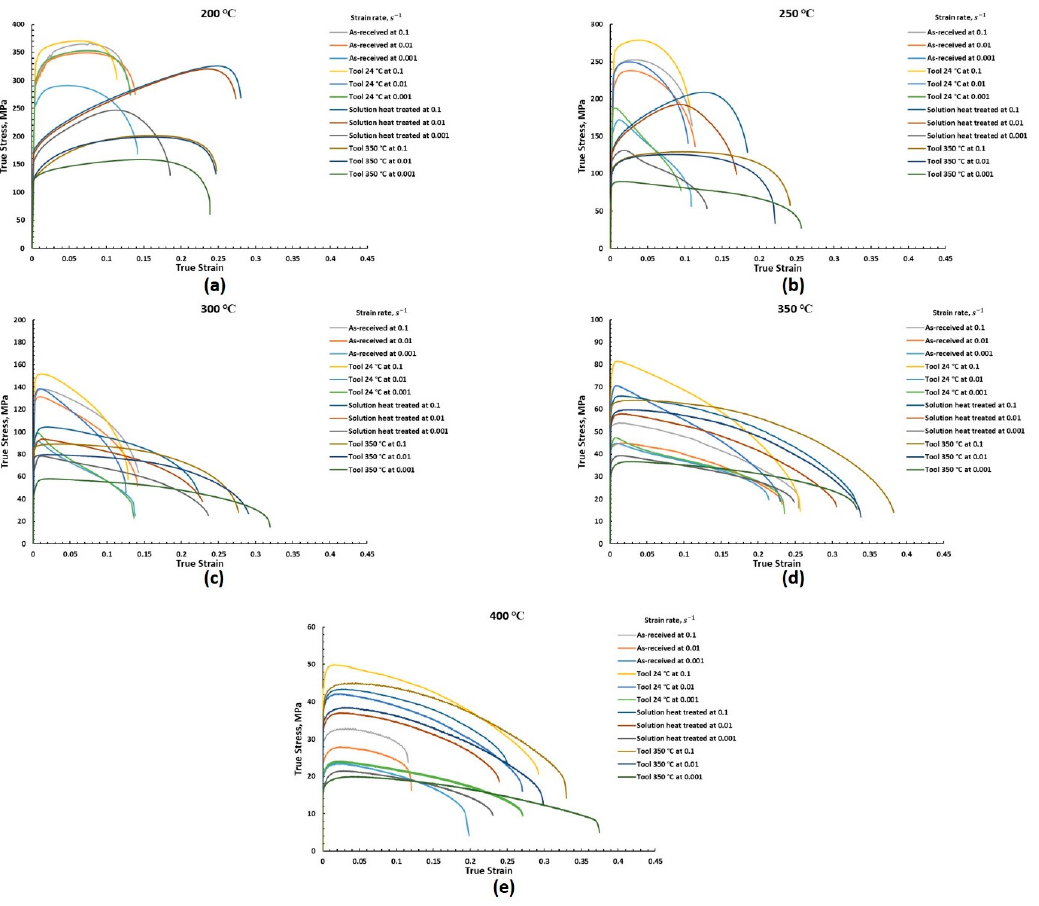
Figure 3. Elevated temperature flow behavior of AA 7075 at various strain rates and deformation temperature of ( a ) 200 °C, ( b ) 250 °C, ( c ) 300 °C, ( d ) 350 °C and ( e ) 400